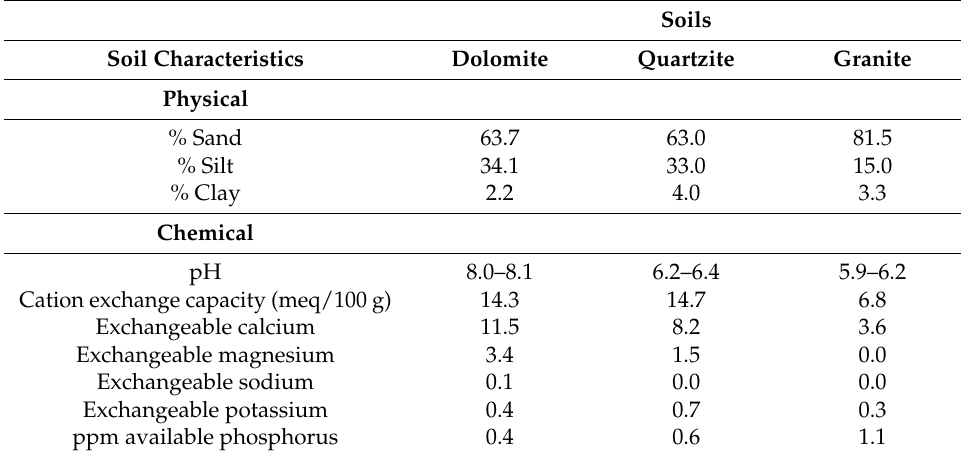
Table 1. Soil characteristics of the three major soil types at treeline in the White Mountains. Table is recreated from Wright and Mooney (1965)